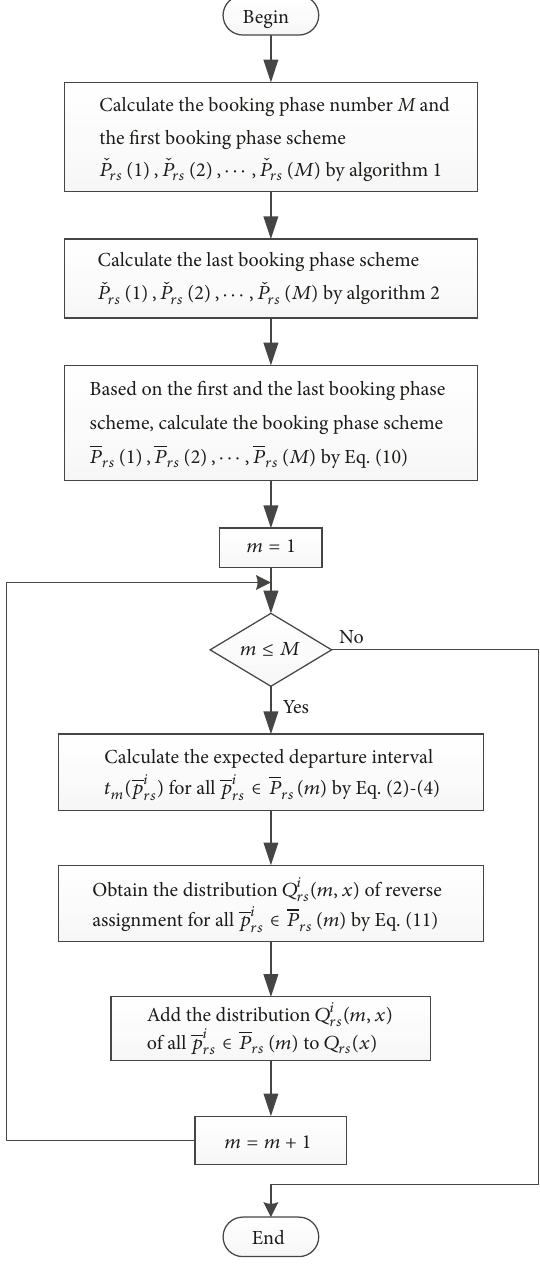
Figure 10: The flow diagram of the MBPRA algorithm. Then, the tickets booking volume 𝑞 𝑖 of 𝑝 𝑟𝑠 is reversely assigned to sion, we design the Multiple Booking Phases Reverse Assign- ment (MBPRA) algorithm, which is shown in Appendix F, to estimate HSR time-varying demand, and the flow diagram of MBPRA algorithm is shown in the Figure